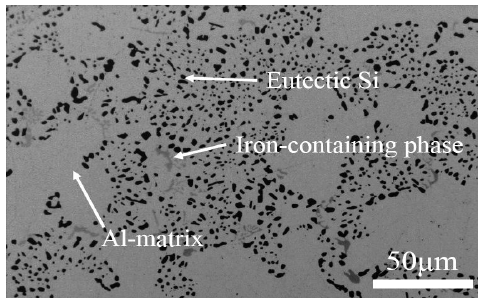
Figure 1. Typical scanning electron microscope (SEM) image showing the microstructure of as-received AlSi10Mg(Cu) alloy.